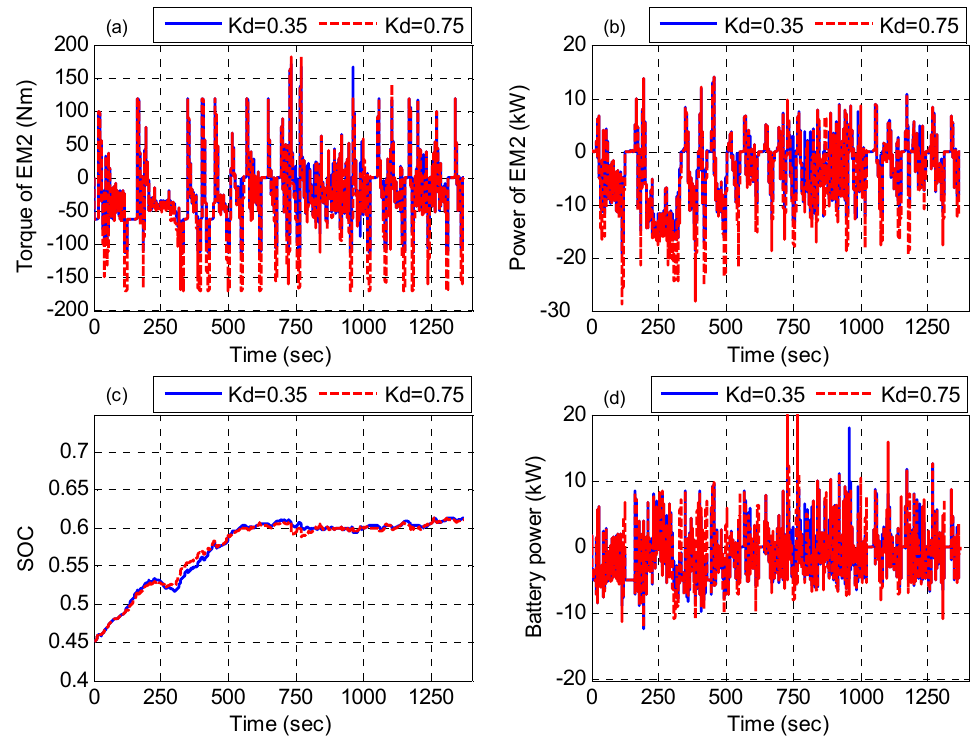
Figure 11. Performance of EM2 and the battery at (cid:1837) UDDS cycle.